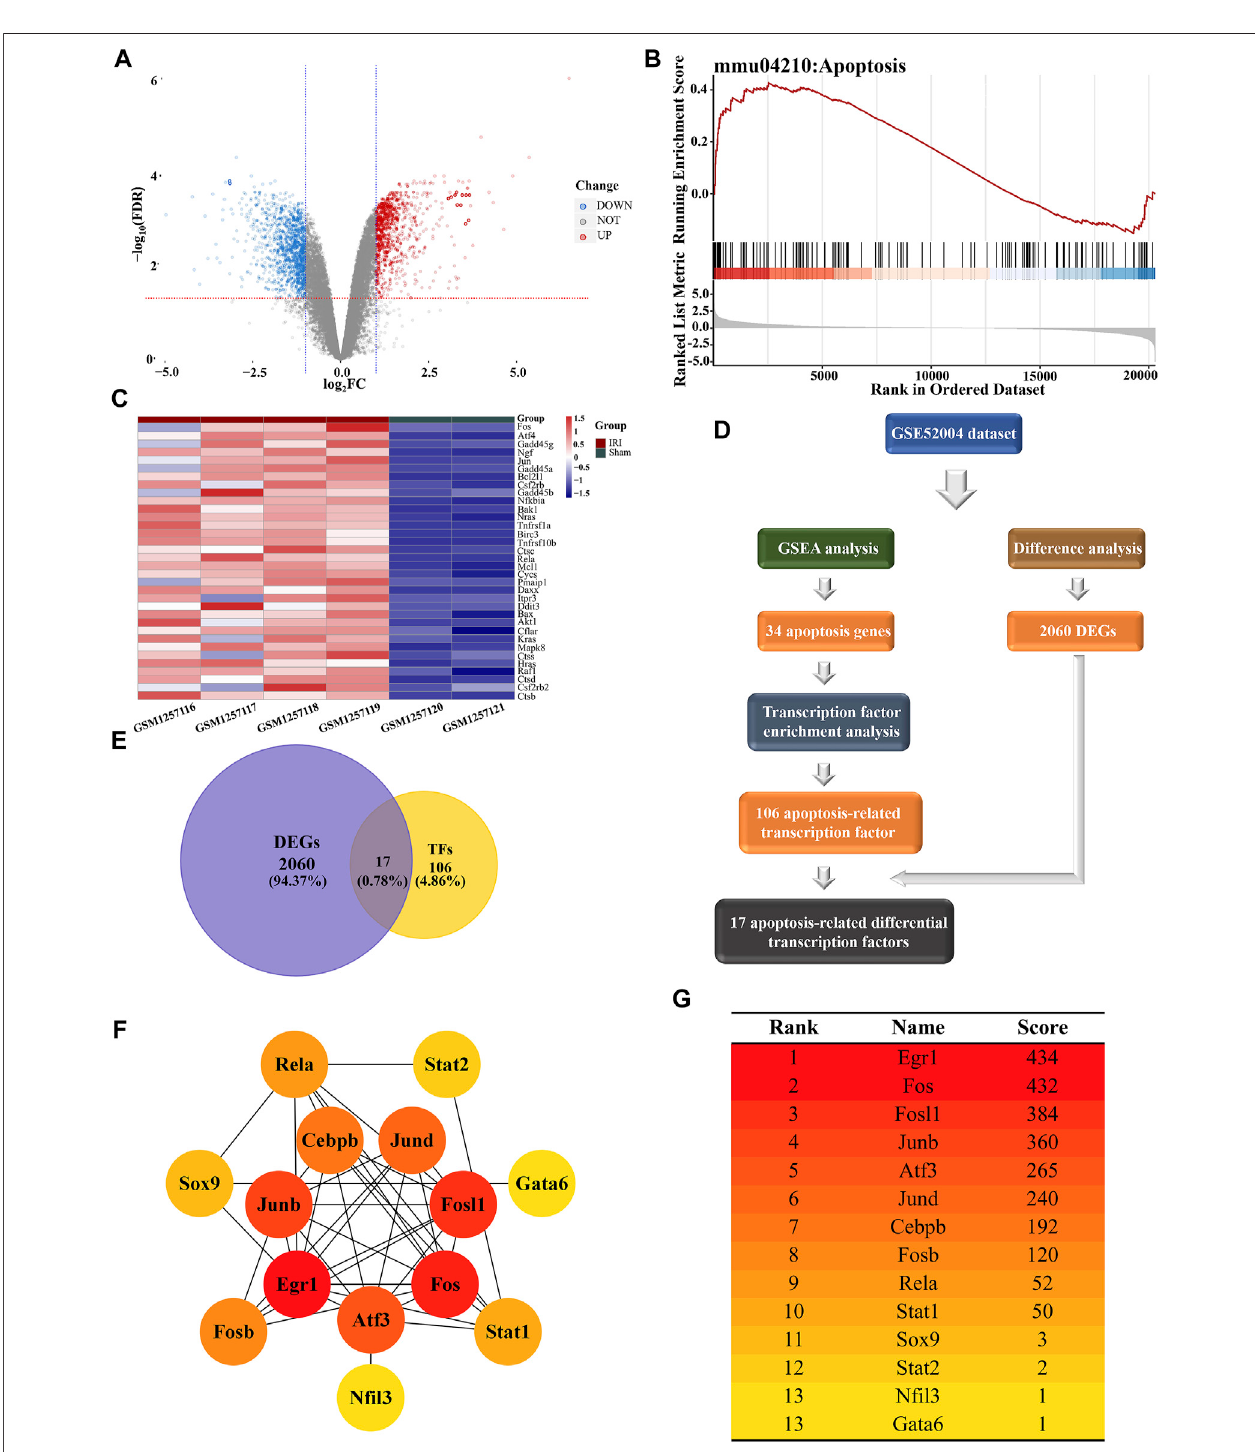
FIGURE 5 | Bioinformatics analysis conducted for apoptosis-related differential transcription factors. (A) Volcano plot of GSE52004 illustrated the DEGs identi fi ed by quantitative analysis. The red horizontal dashed line represents -log 10 (FDR=0.05), and the two blue vertical dashed lines represented log 2 FC=-1 and log 2 FC=1, respectively. Among the DEGs, 943 upregulated genes were marked in red dots, while 1,117 downregulated genes were marked in blue dots. (B) GSEA of microarray data shows the enrichment plot of the apoptosis pathway for sets of genes in the GSE52004 dataset. NES=1.4913. (C) Heatmap showed the expression of 34 apoptosis-related genes in the GSE52004 dataset. The color of each section was proportional to the signi fi cance of changes in apoptosis (red indicated increase;